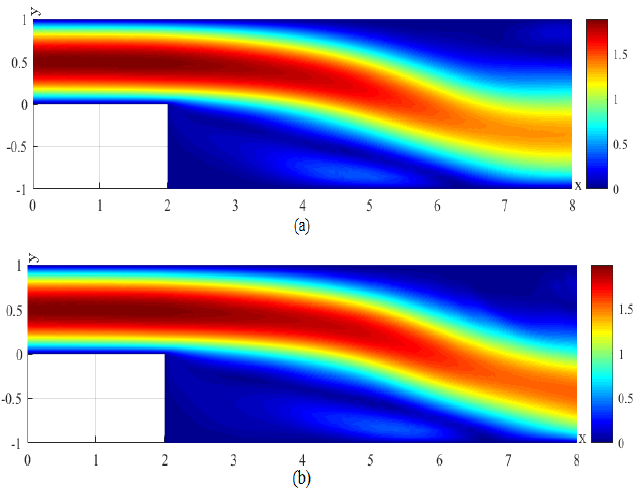
Figure 12. ( a ) The velocity magnitude for the CNMFE solution at t = 8. ( b ) The velocity magnitude for the RDRCNMFE solution at t = 8.